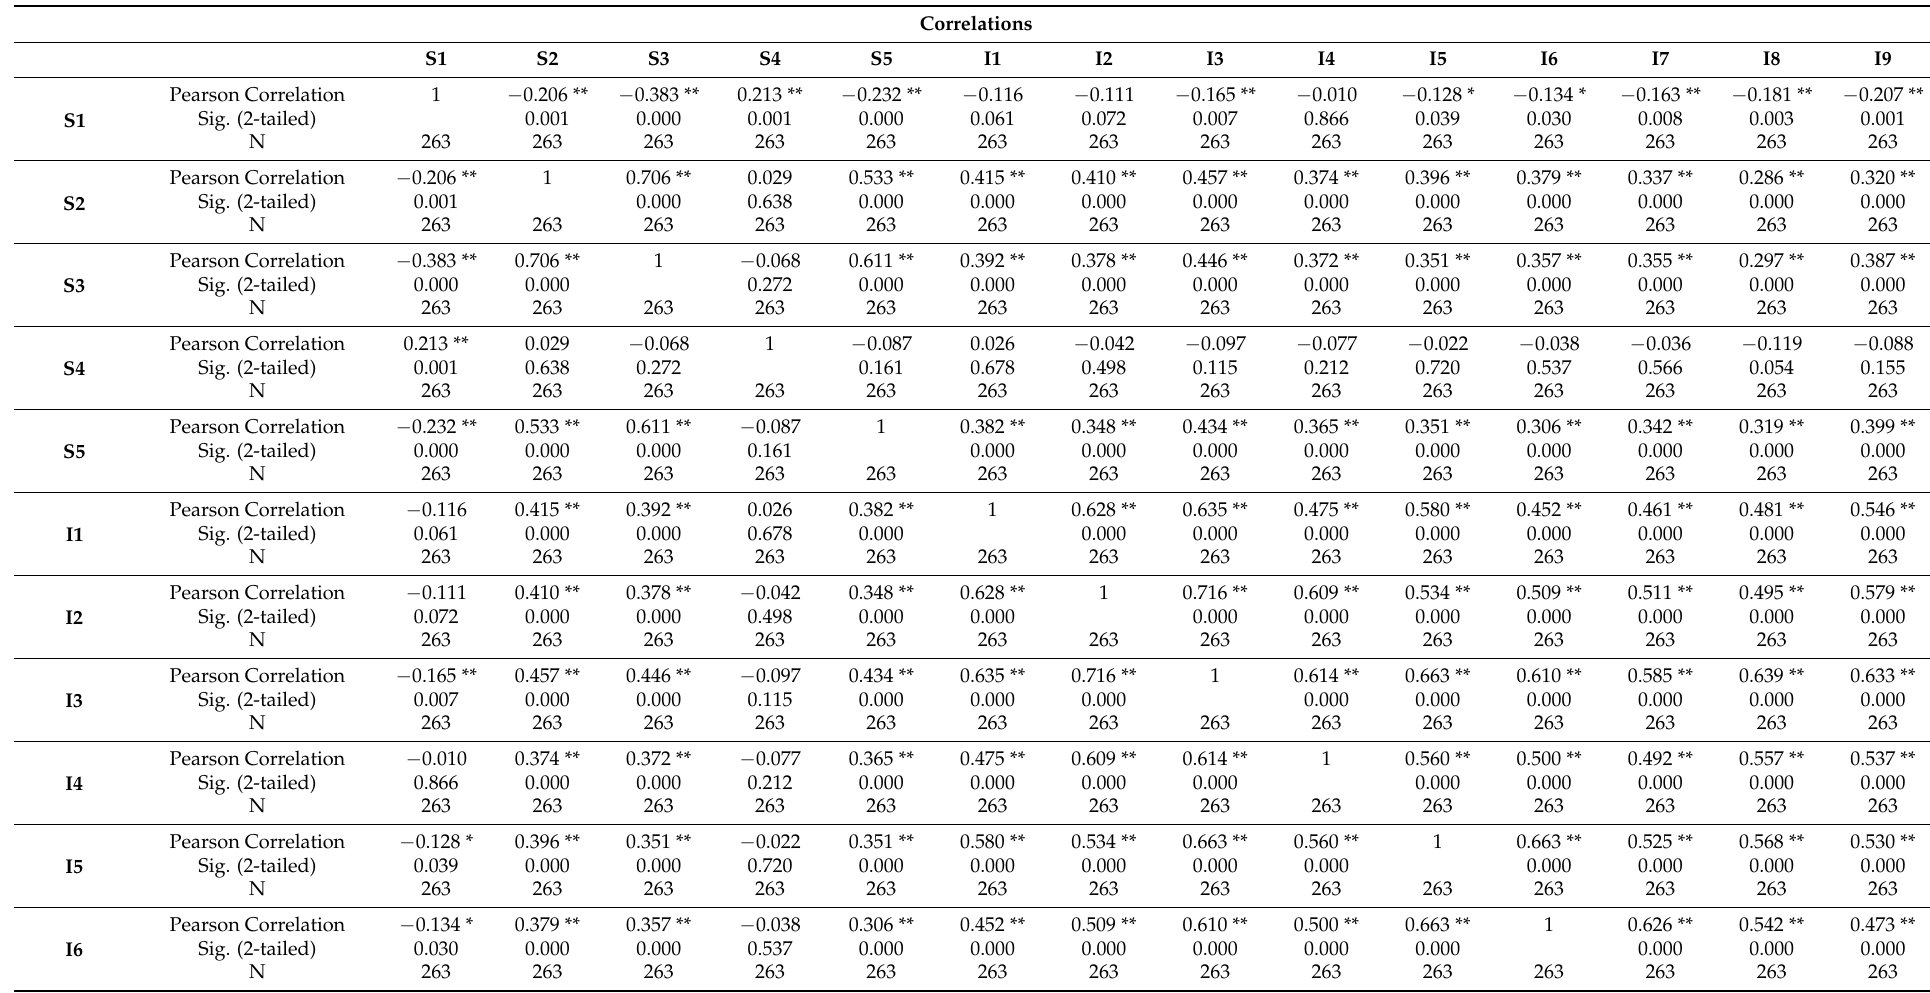
Table 1. Correlation between the items of the variables ‘decision to purchase clothing’ and ‘the importance of brand